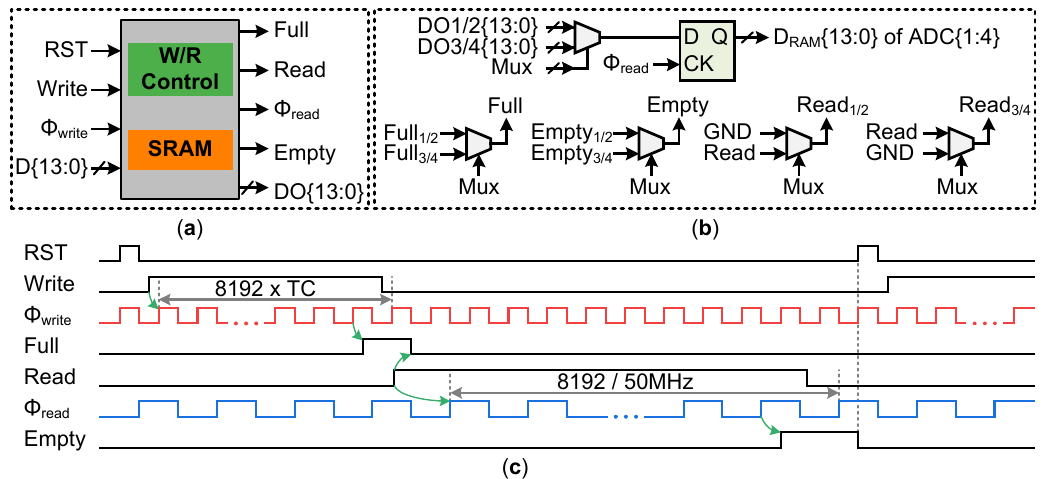
Figure 8. FIFO details: ( a ) Functional block diagram; ( b ) The data selecting and sharing hardware for the adjacent channels; ( c ) The timing diagram for the